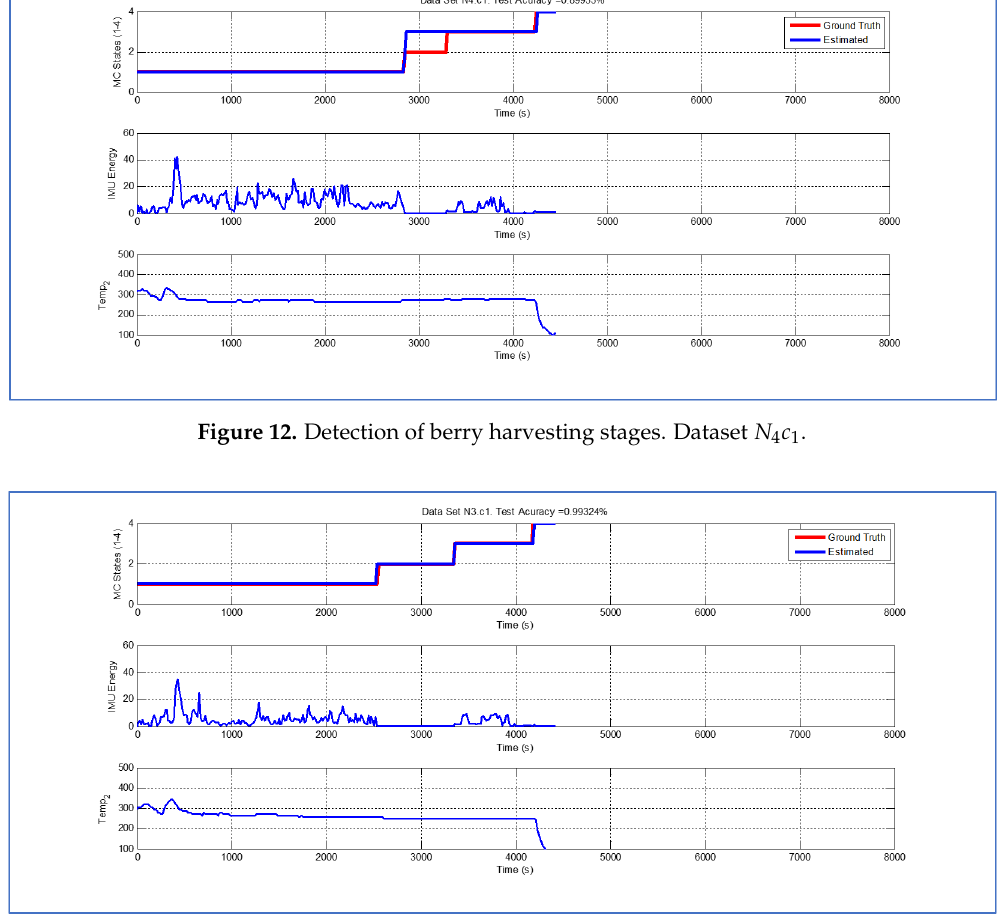
Figure 13. Detection of berry harvesting stages. Dataset N 3 c 1